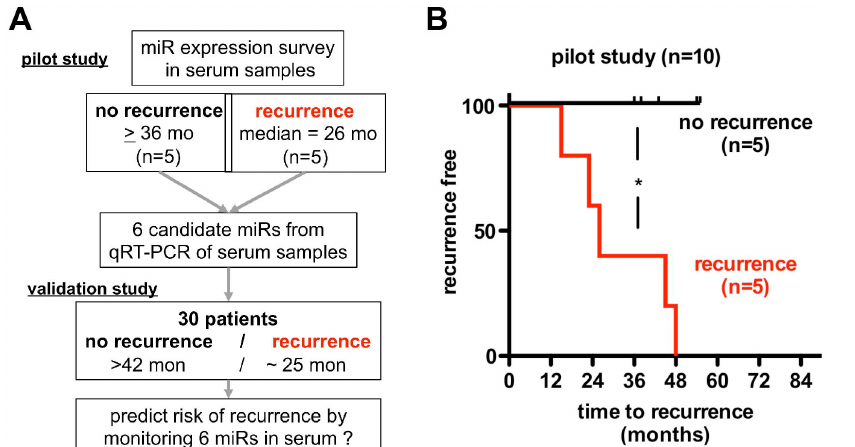
Figure 1. Study design (A) and time-to-disease recurrence in early stage colon cancer patients in the pilot study (B). A , From a pilot study with 10 patients candidate miRs predictive of disease recurrence were identified and tested for their prediction of disease recurrence in a validation study. B , Kaplan-Meier plot of disease recurrence in patients in the pilot study. Patients with disease recurrence (n=5) vs no recurrence (n=5): Chi square 5.47, p=0.0193; median time-to-recurrence=26 months. The Gehan-Breslow-Wilcoxon algorithms were used.